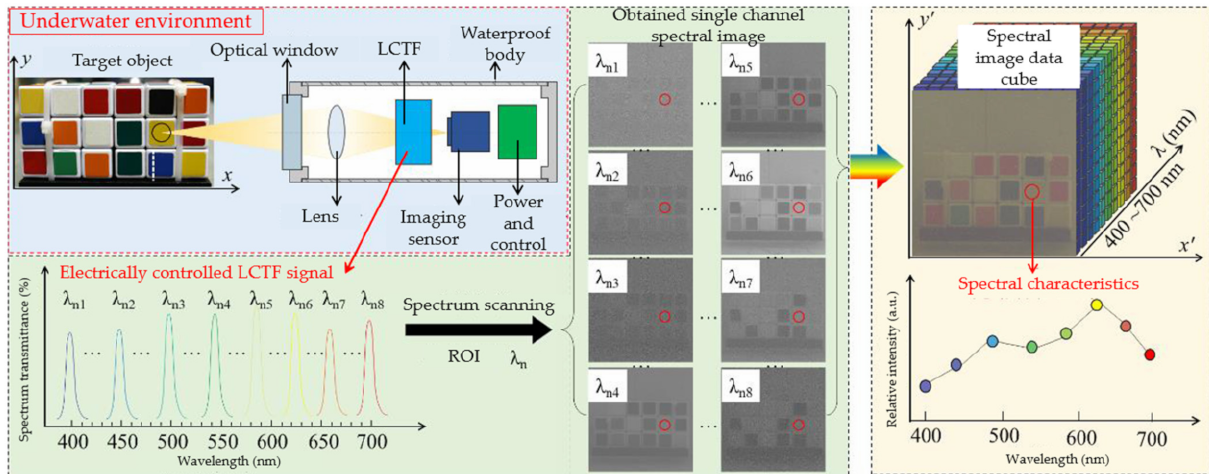
Figure A2. The optical module’s brief schematics explain the working principle of the designed USI prototype to obtain spectral image data cube in underwater